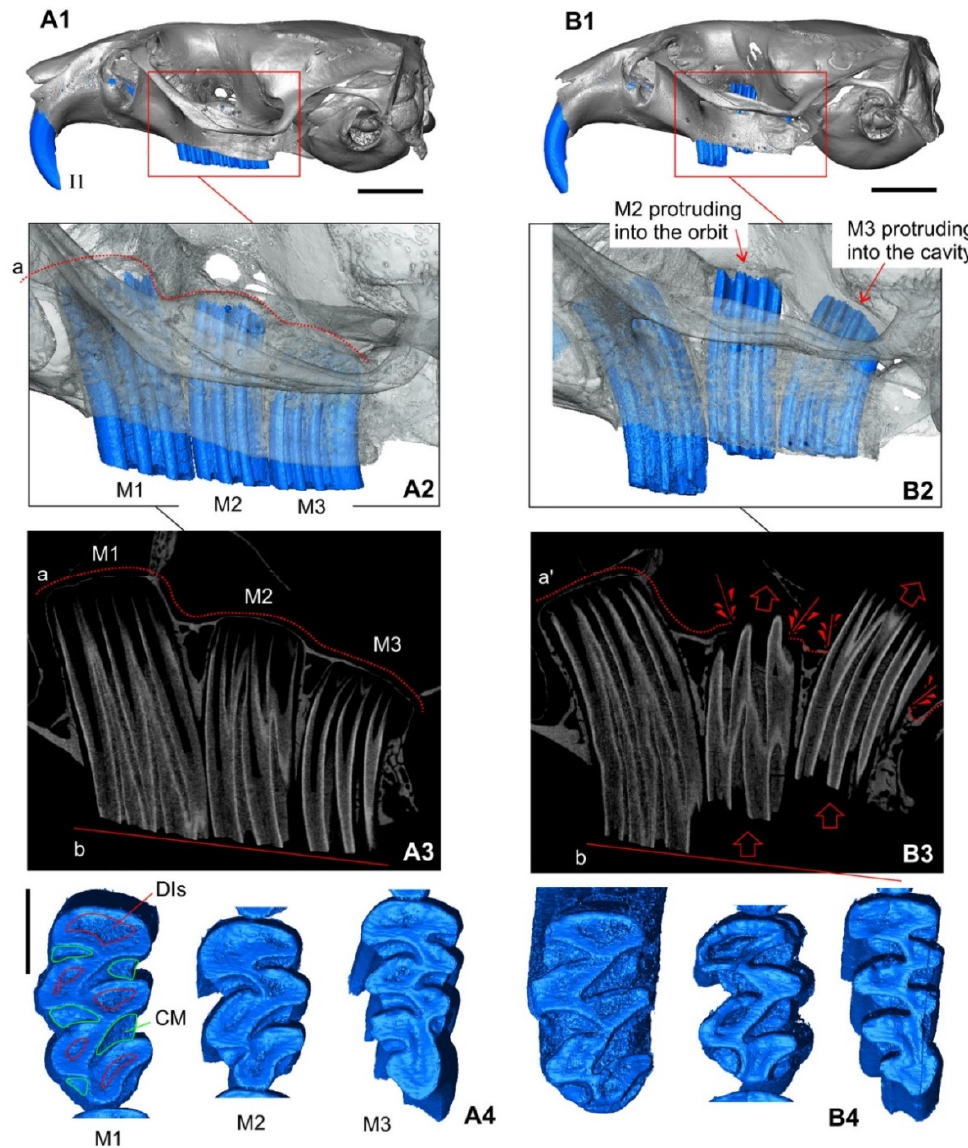
Figure 4. 3D models of the skulls and upper molars (M1, M2, M3) of M. h. ankaraensis (ZIN 98971; A ) and M. hartingi (ZIN 107168-10 from the Eastern Rhodopes; B ). ( A1 , B1 ) Models of skulls in lateral view. ( A2 , B2 ) Models of the orbital part of skulls in transparent view showing the molars’ positions. ( A3 , B3 ) X-ray images of molars in parasagittal cut view. ( A4 , B4 ) Models of upper molars in occlusal view. Abbreviations. a: the red dotted line indicates the approximate position of the alveolar roof under usual conditions; a’: broken alveolar roof; b: occlusal profile of the molar row; CM: cementum; DIs: dentine islet; red wide arrows: the direction of molars’ submersion. The scale bars are 5 mm ( A1 , B1 ) and 1 mm ( A4 , B4 ).